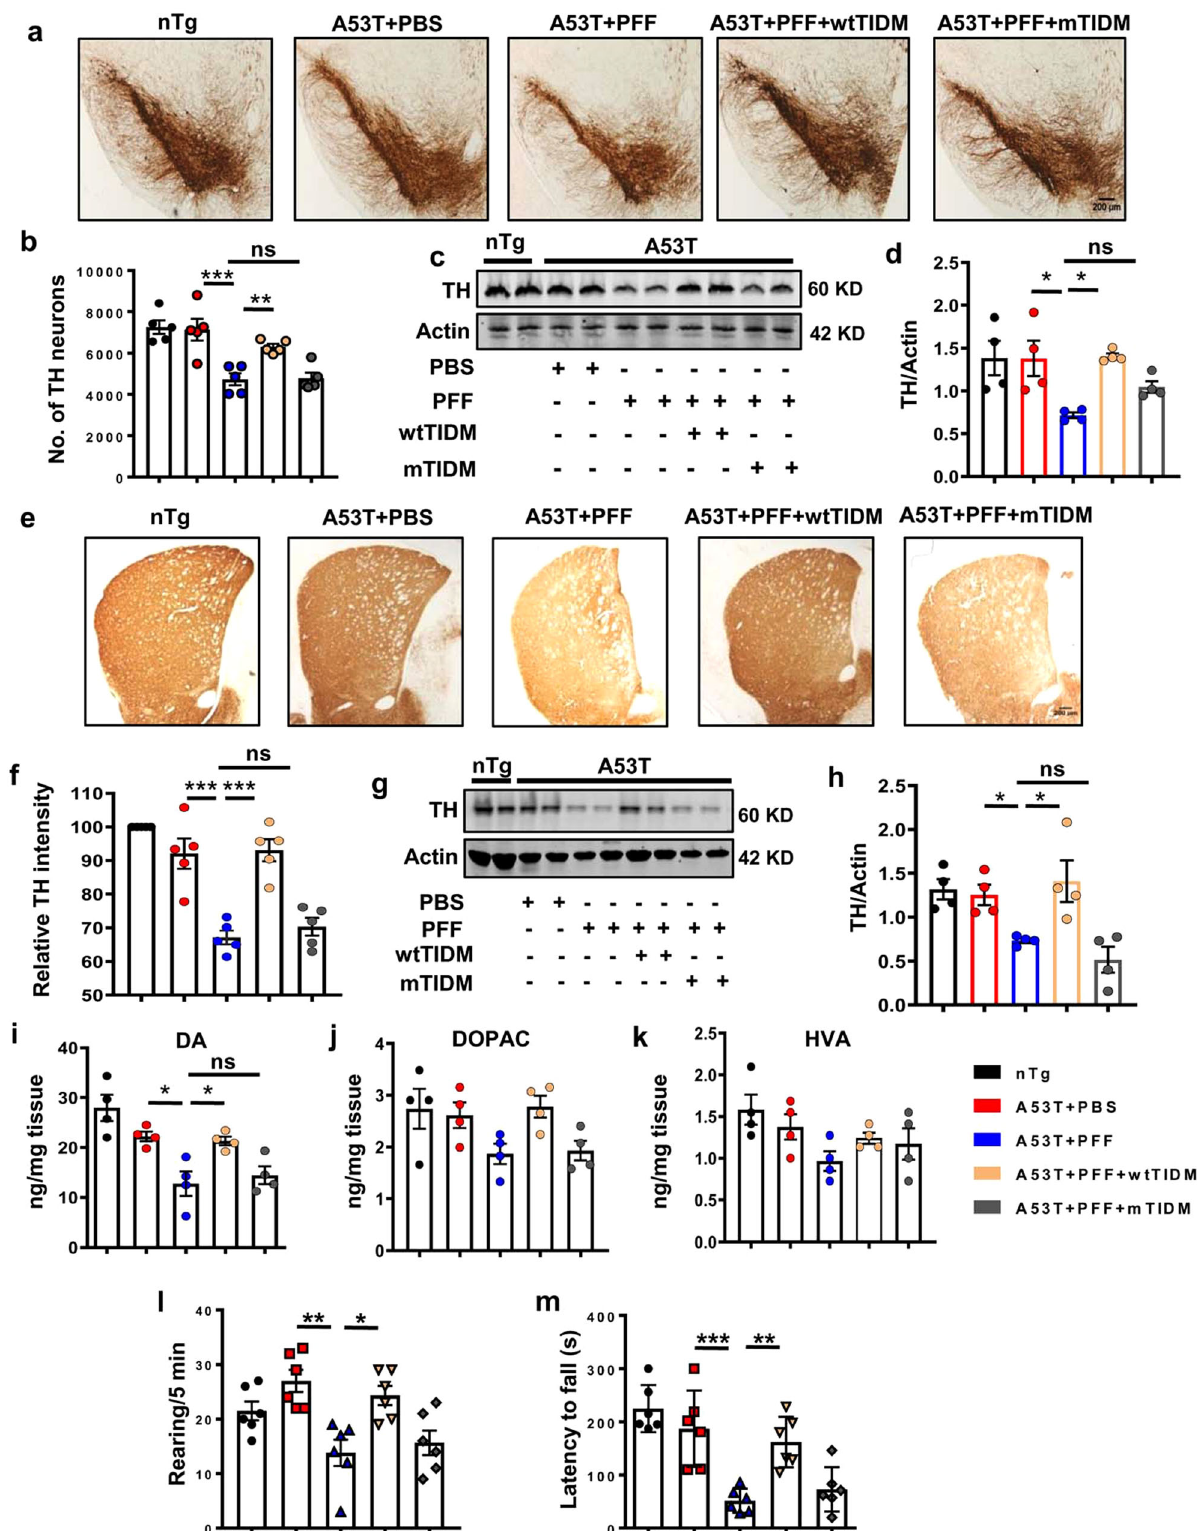
the aged A53T animals. As expected, A53T animals exhibited poor performance in the pole test as these mice took a longer time to turn downward (pole turn time) on the pole and to reach the base (climb downtime) of the pole (Supplementary Fig. S10n, o). However, consistent with the suppression of α -syn spreading,